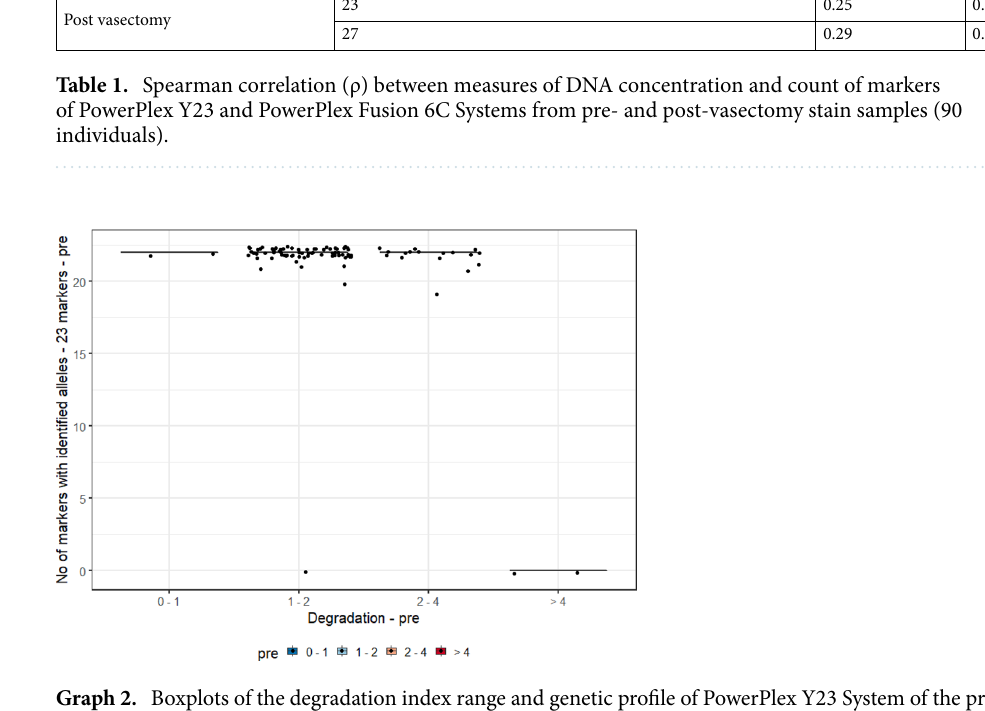
Graph 2. Boxplots of the degradation index range and genetic profile of PowerPlex Y23 System of the pre- vasectomy samples (n = 90